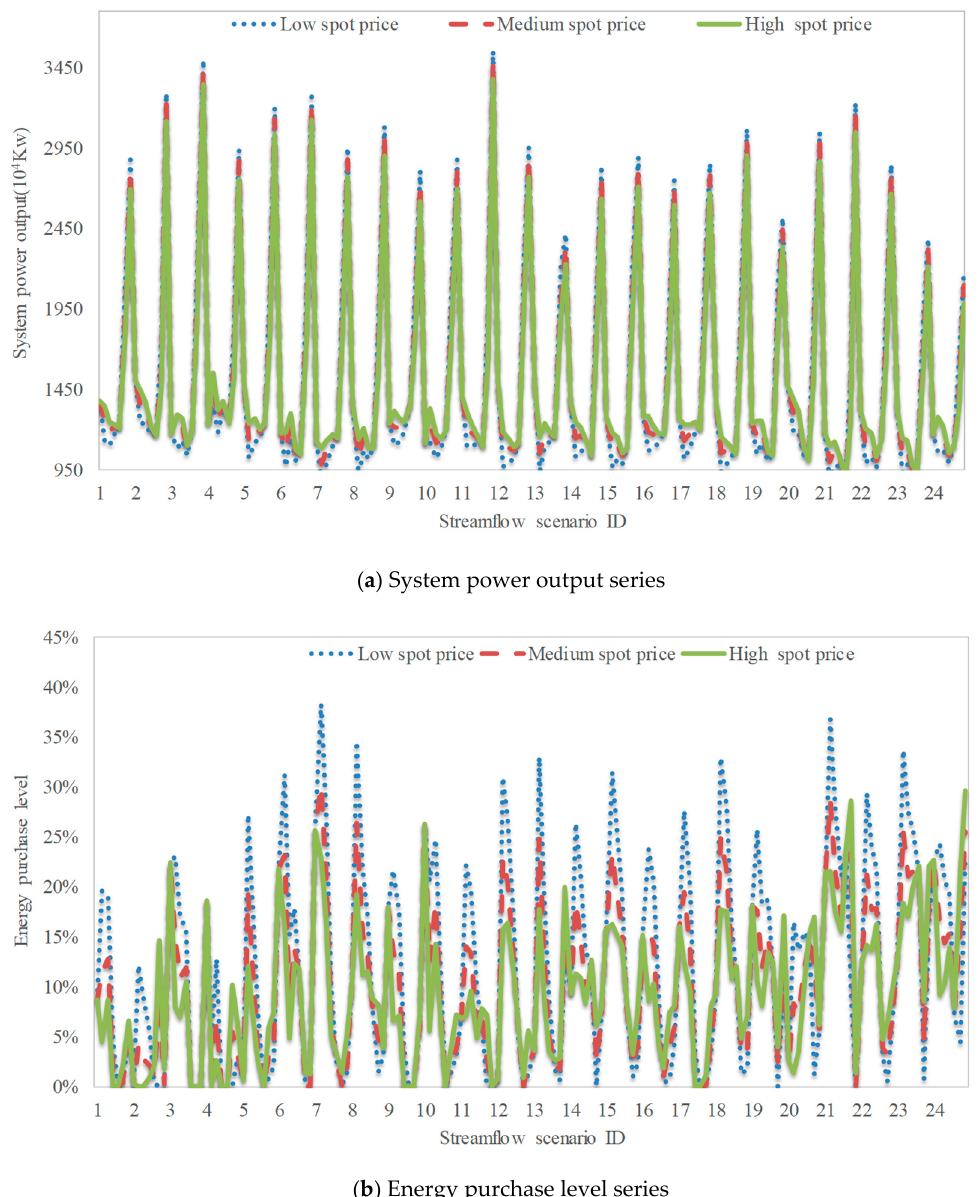
Figure 5. System power output and energy purchase level results under different streamflow scenarios and λ .